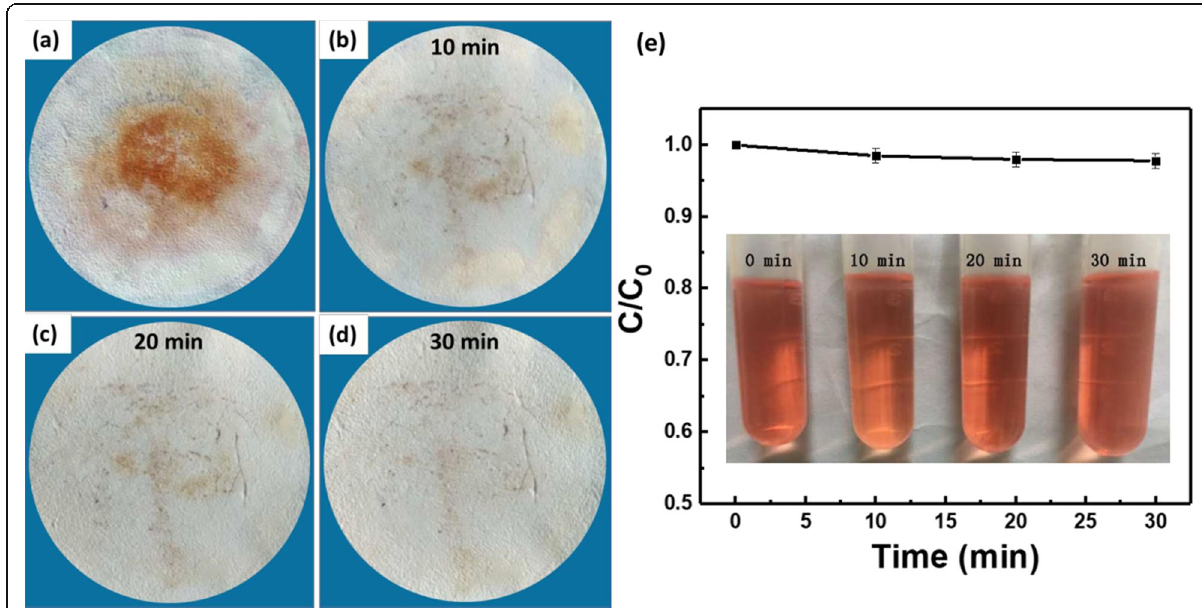
Fig. 8 Optical picture of the membrane after oil/water separation and self-cleaning ( a ) and the optical pictures of this membrane irradiated under UV-light for 10 min ( b ), 20 min ( c ), and 30 min ( d ). e Degradation efficiency of methyl red solution without photocatalyst under irradiation of UV-light. Inset is the optical photo of methyl red solution irradiated at different